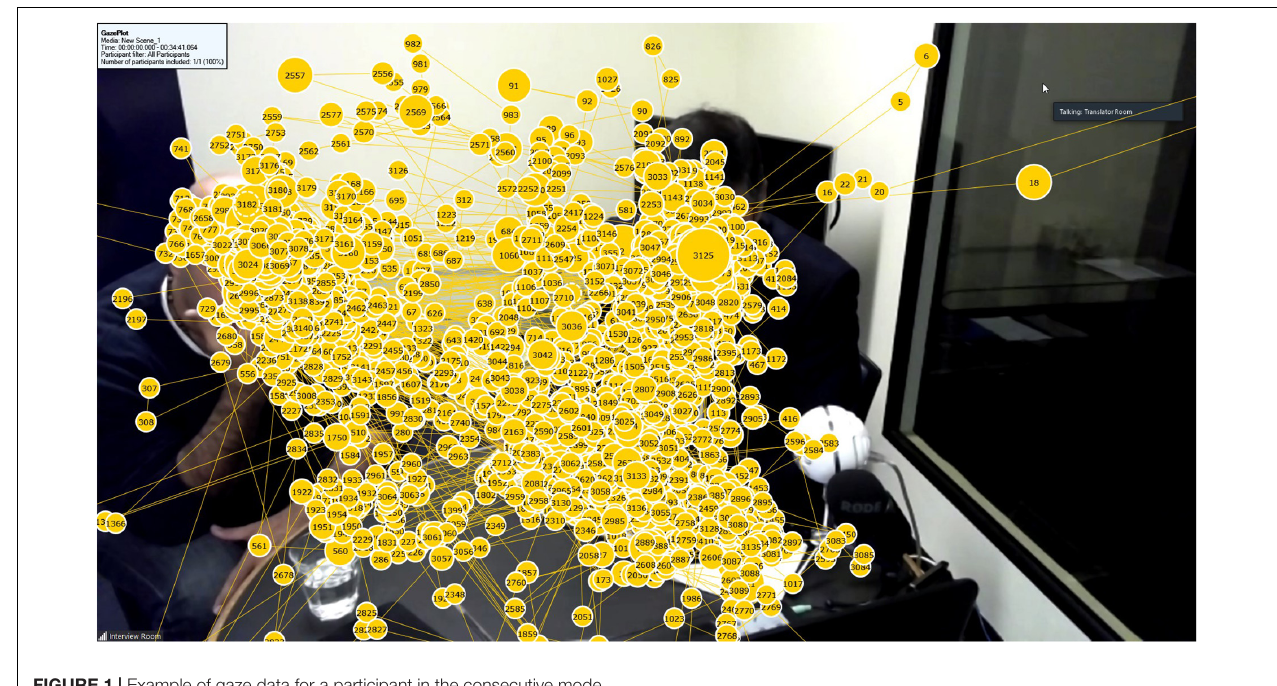
FIGURE 1 | Example of gaze data for a participant in the consecutive mode.